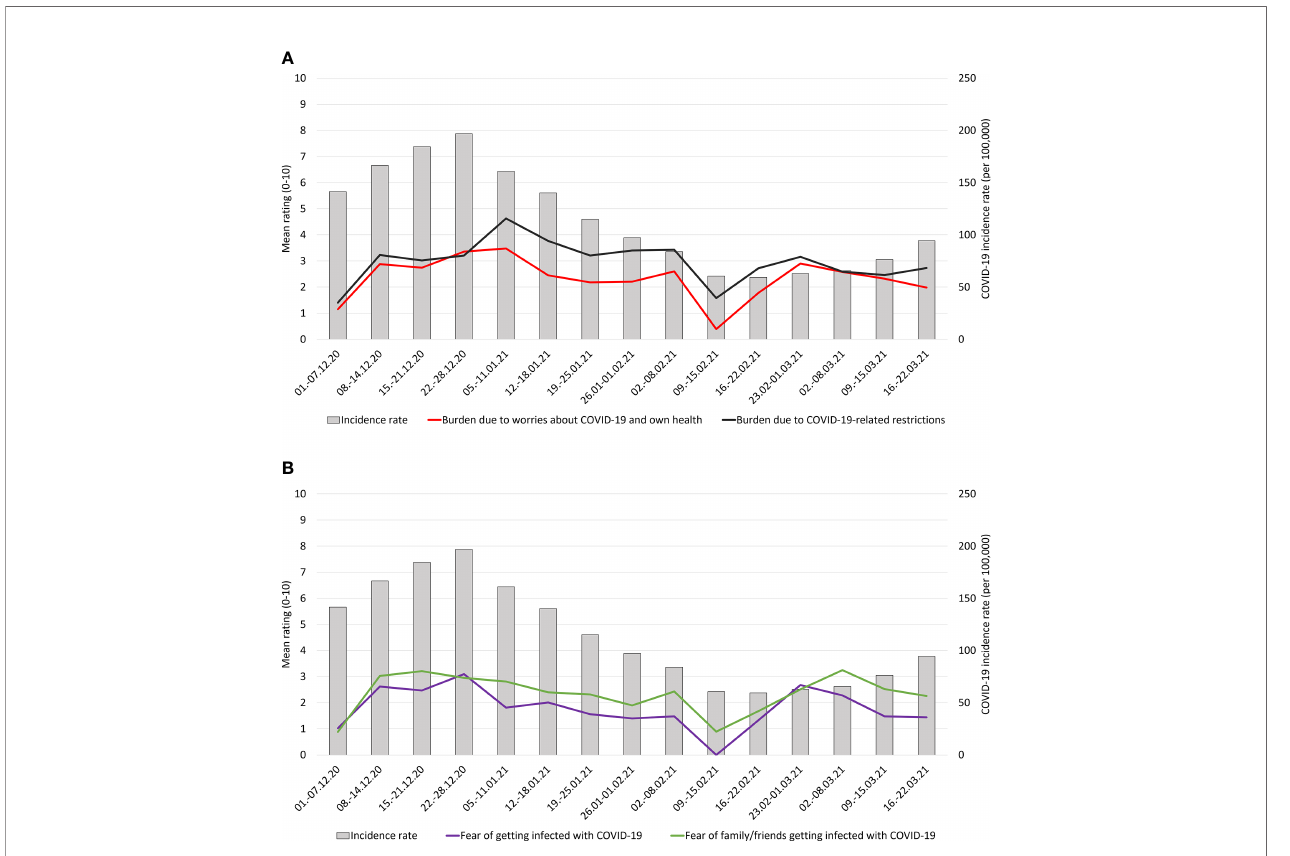
FIGURE 2 | Course of COVID-19-related burdens (A) and fears (B) displayed against concurrent incidence rates over the study